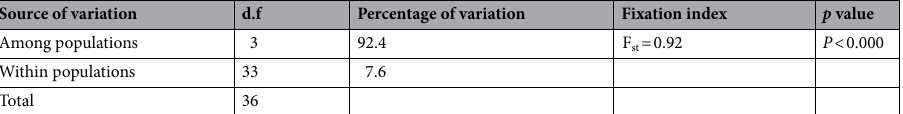
Table 2. AMOVA results for Testudo graeca populations in the contact zone of T. g. zarudnyi and T. g. boxtoni based on the 948 bp of cytochrome b gene sequences.